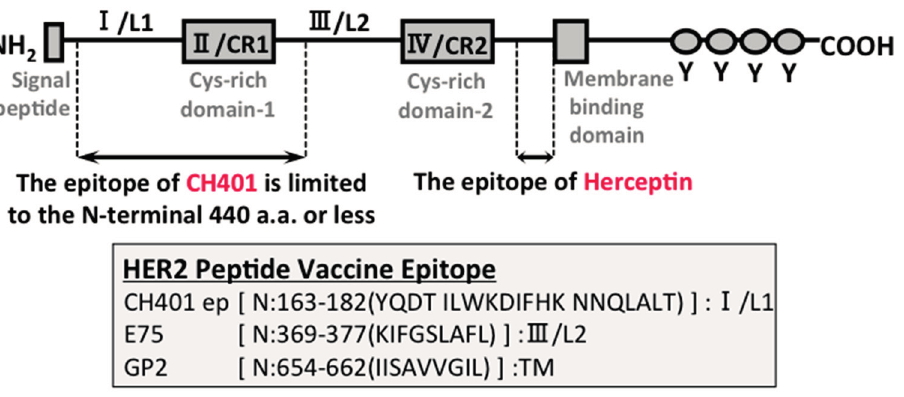
Figure 2. The structures of Her2 and the Her2 peptide vaccine epitopes. The structures of Her2 and the breast cancer vaccine epitopes are shown, as reviewed by Roscoski Jr [18]. 3. Why Can Peptide Vaccines Not Fully Induce Cellular Immunity to Reject Established Cancerous